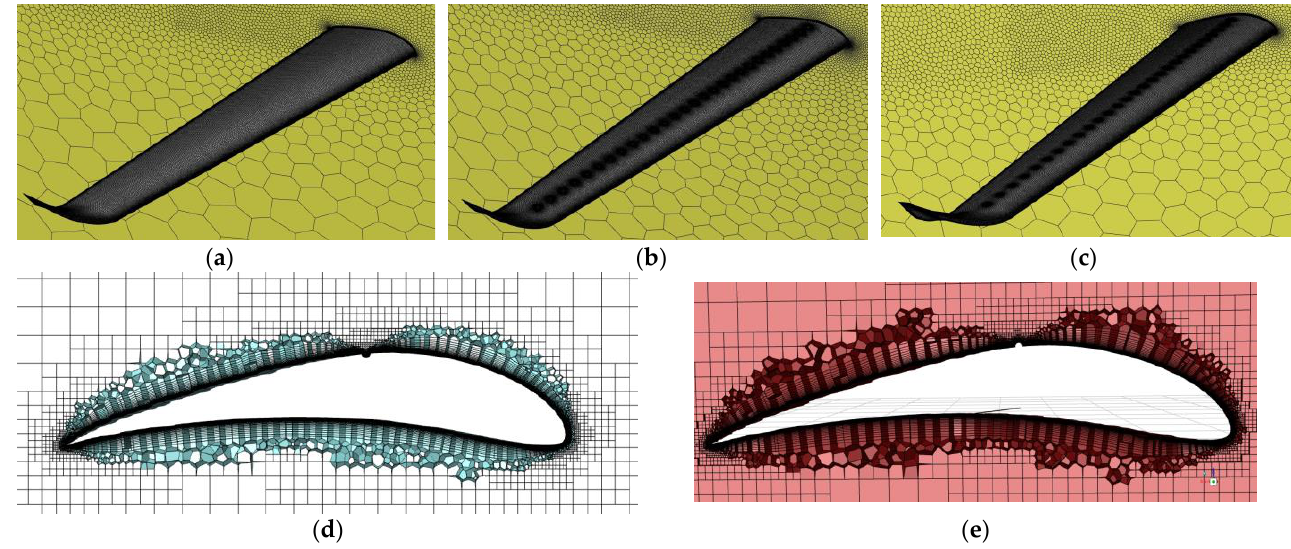
Figure 7. Domain of the three-dimension grid of the ( a ) original wing, ( b ) wing with dimples, and ( c ) wing with bumps, and volumetric meshes of the wing ( d ) with dimples and ( e ) with bumps.